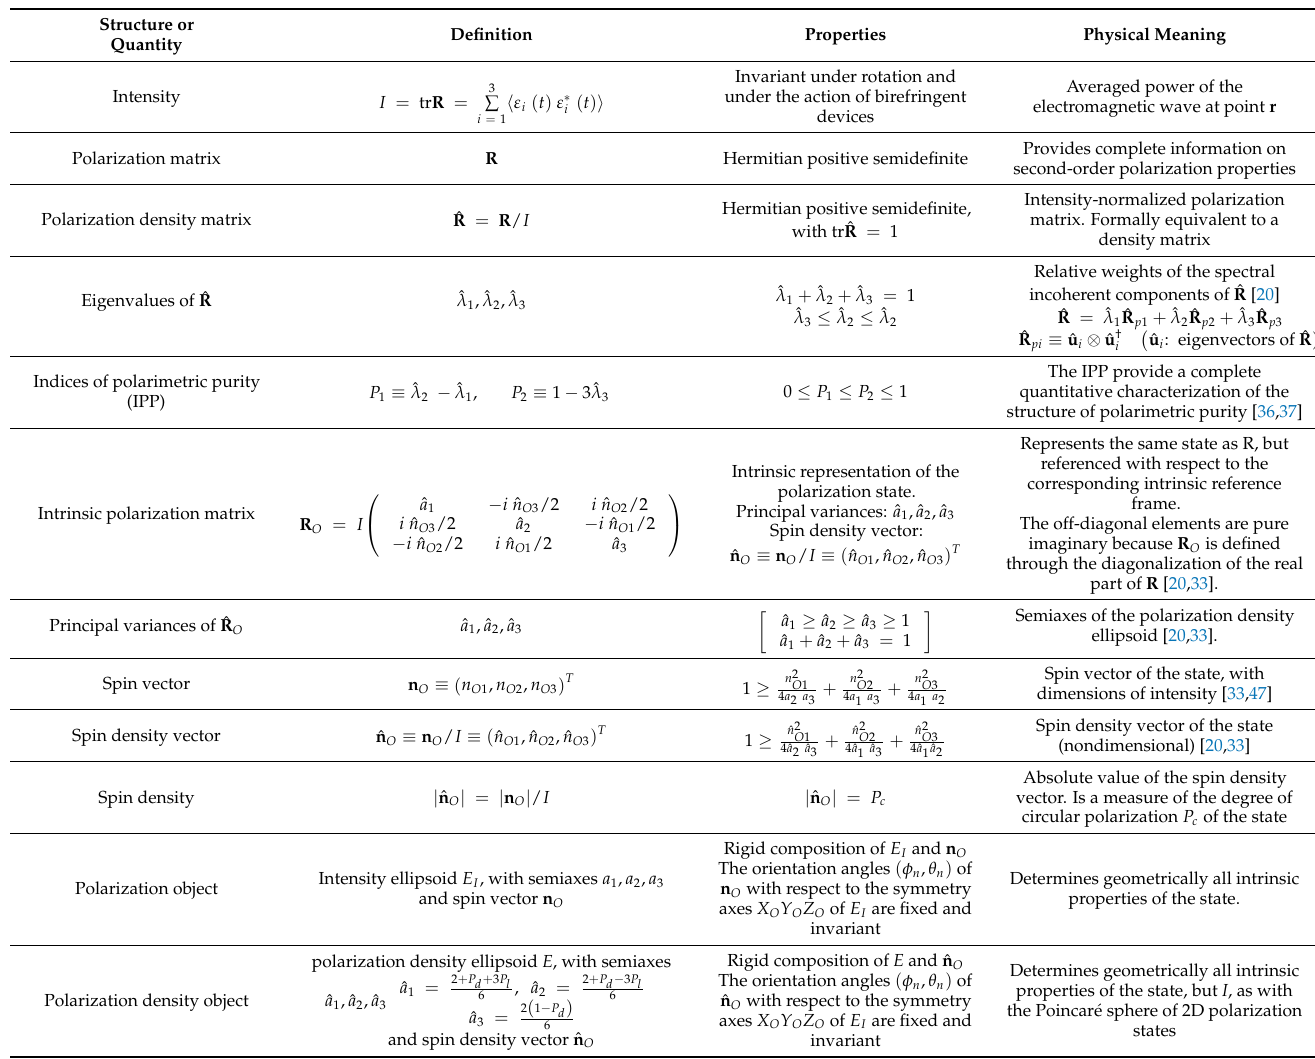
Table A1. Quantities and structures relative to three-dimensional polarization